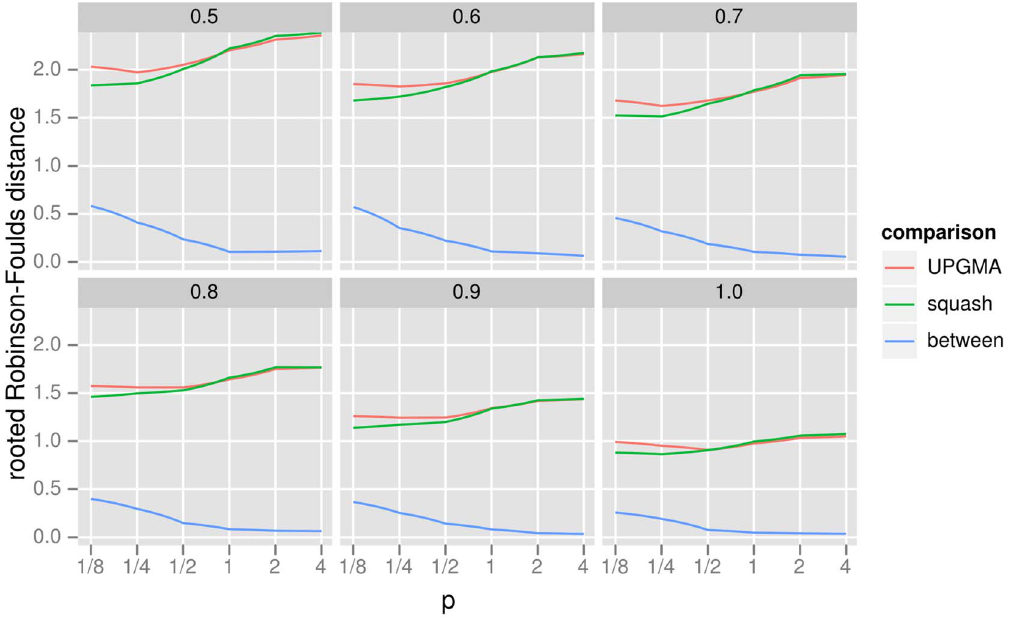
Figure 9. The results of the cluster accuracy simulation experiment using the rooted Robinson-Foulds (RF) metric. This graphic shows very similar levels of topological accuracy for squash clustering and UPGMA, as well as high similarity between the topology returned by the two methods. The figure is divided into panels by the level of reconstructability parameter r t as described in the text (a larger r t implies easier reconstruction). The x -axis is the value of p for the Z p distance as described in (1). The y -axis is the rooted Robinson-Foulds distance: for the ‘‘squash’’ and ‘‘UPGMA’’ lines it is the distance between the reconstructed tree and the original tree using these two algorithms (lower is more accurate), while the ‘‘between’’ line shows the distance between the result for the two clustering algorithms (lower is more similar). Note that the maximum rooted RF distance between two trees with six taxa is four.